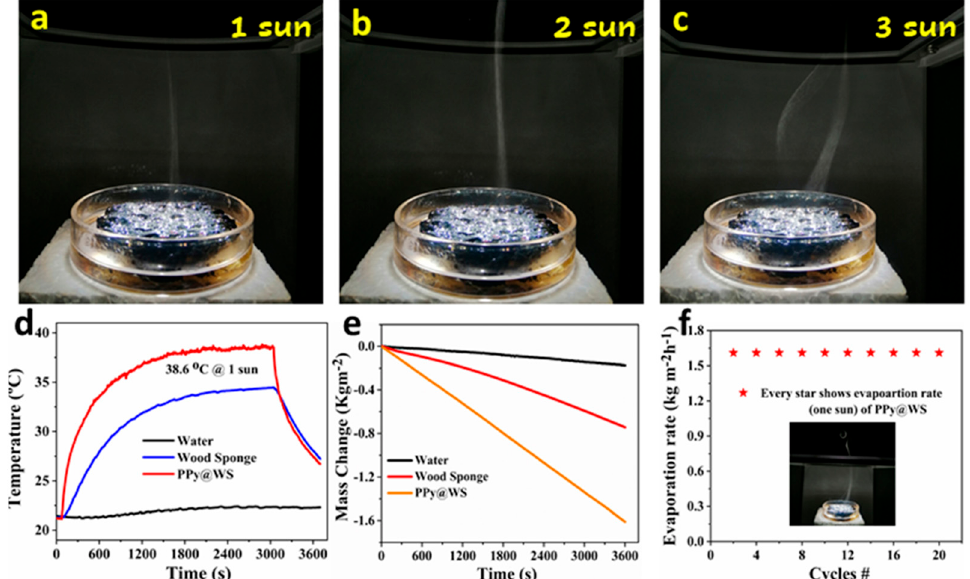
Figure 4. ( a – c ) Real ‐ time demonstration of solar ‐ driven steam generation via PPy@WS solar evaporator under different solar intensities up to 3 kW ∙ m − 2 . ( d ) Surface temperatures of pure water, simple wood pulp sponge, and PPy@WS solar evaporator under 1 kW ∙ m − 2 . ( e ) Mass changes of pure water, simple wood pulp sponge, and PPy@WS solar evaporator under 1 kW ∙ m − 2 . ( f ) Water evaporation rate via PPy@WS solar evaporator under 1 kW ∙ m − 2 for consecutive 20 cycles.